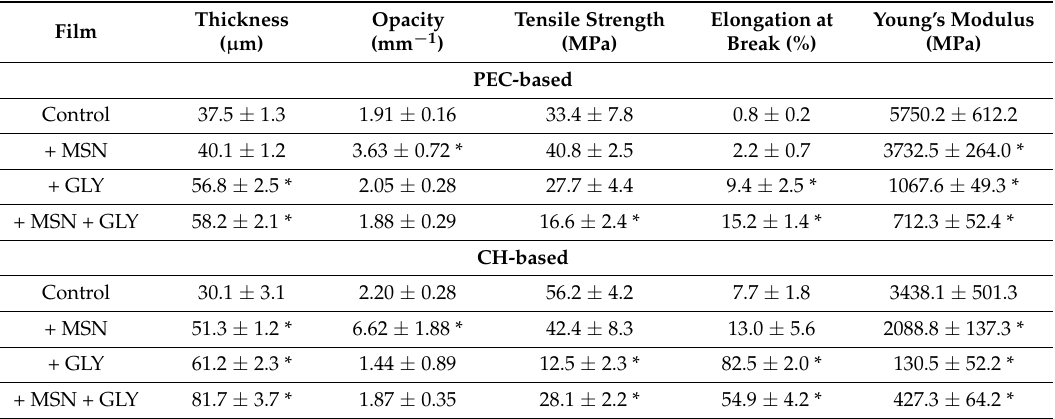
Table 1. Effect of mesoporous silica nanoparticles (MSNs) on film thickness, transparency, and mechanical properties of the pectin (PEC) and the chitosan (CH) films plasticized with glycerol (GLY), or